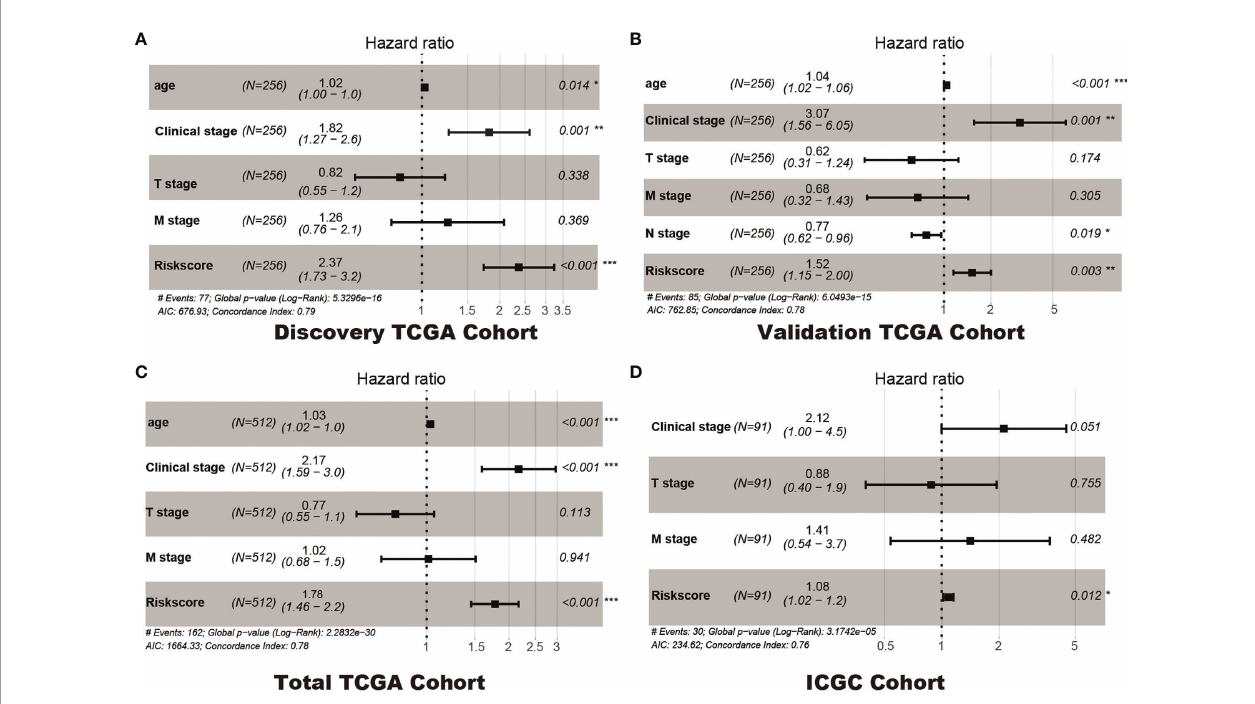
FIGURE 4 | Multivariate Cox regression analyses. Discovery TCGA Cohort (A) , Validation TCGA Cohort (B) , Total TCGA Cohort (C) and ICGC Cohort (D) . *p < 0.05, ** p < 0.01, *** p < 0.001